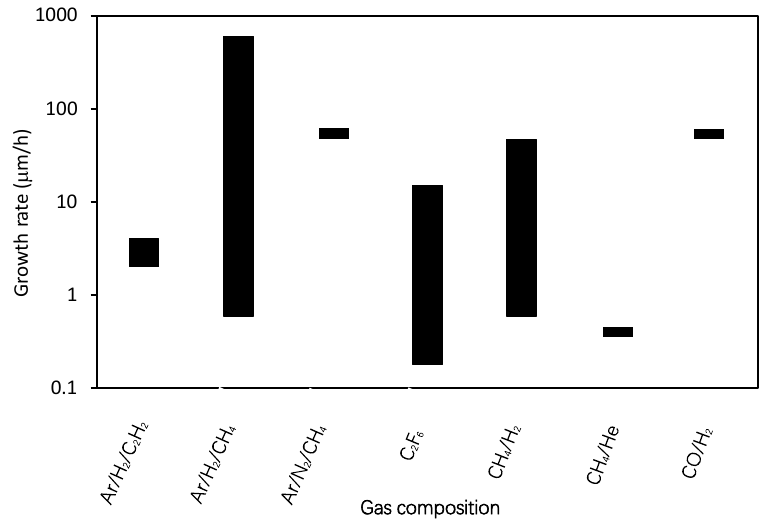
Figure 6. The growth rate for different gases as reported in literature shown in Table 1. The height of the bars indicates the range of growth rates found in the literature.